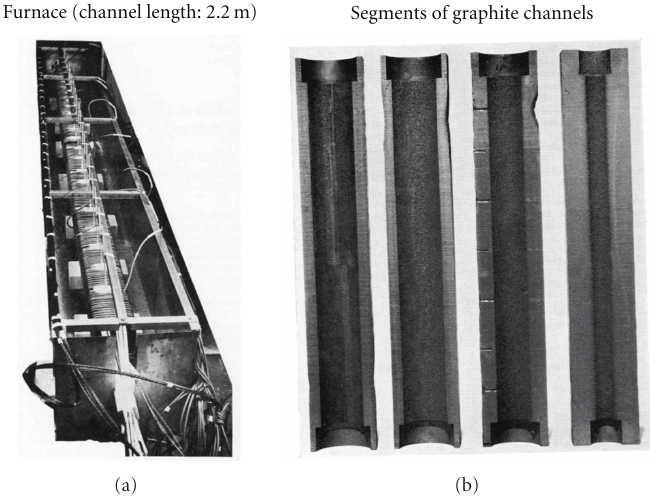
Figure 3: BNL furnace for burning experiments on graphite channels and channel segments